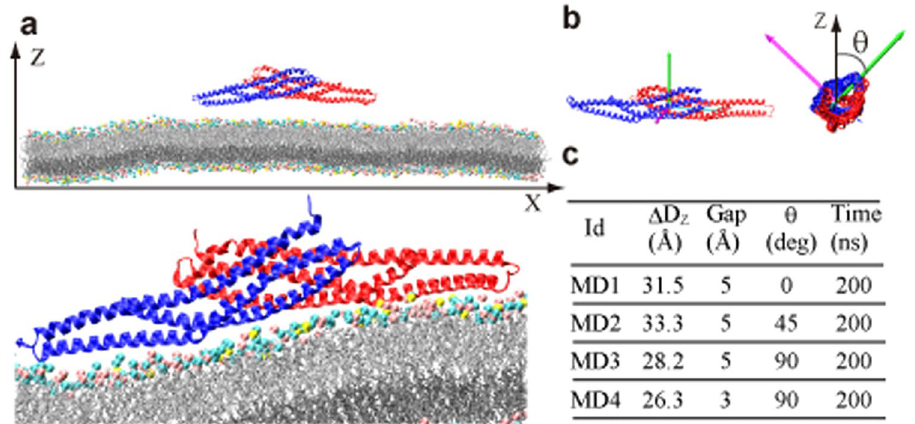
Figure 1. Simulated system containing I-BAR and a lipid bilayer membrane. ( a ) The initial arrangement of I-BAR (upper panel) and a snapshot after 200-ns MD (lower panel) in the MD1 simulation. Pink, cyan, and yellow spheres represent the headgroups of DOPC, DOPE, and DOPS, respectively. ( b ) Principal axes of inertia of I-BAR (three arrows). The angle θ is defined as the angle between the second principle axis of inertia (green) and the Z-axis; the latter is initially parallel to the membrane normal in MD1. ( c ) Initial conditions of the four MD simulations of I-BAR–membrane systems (MD1–4). Δ D Z is defined in the main text. ‘Gap’ is the minimum heavy atom pair distance between I-BAR and the membrane along the Z-axis. The molecular graphics was created by VMD 57